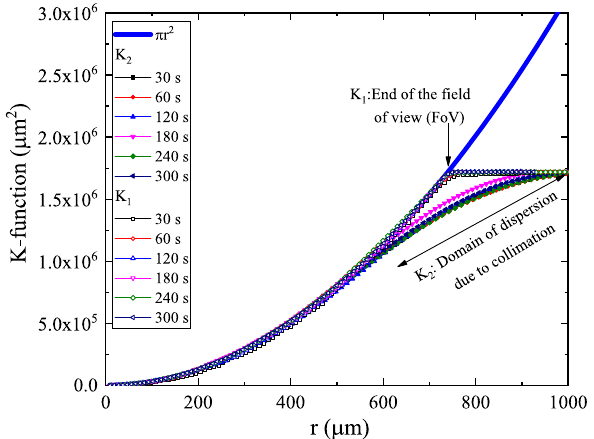
Figure 14. Plot of the cumulative radial distribution function K 1 ( r ) and K 2 ( r ) for samples a4, b4/1, c4, d4/1, e4, 2 and f4. The values of π r were added for comparison.